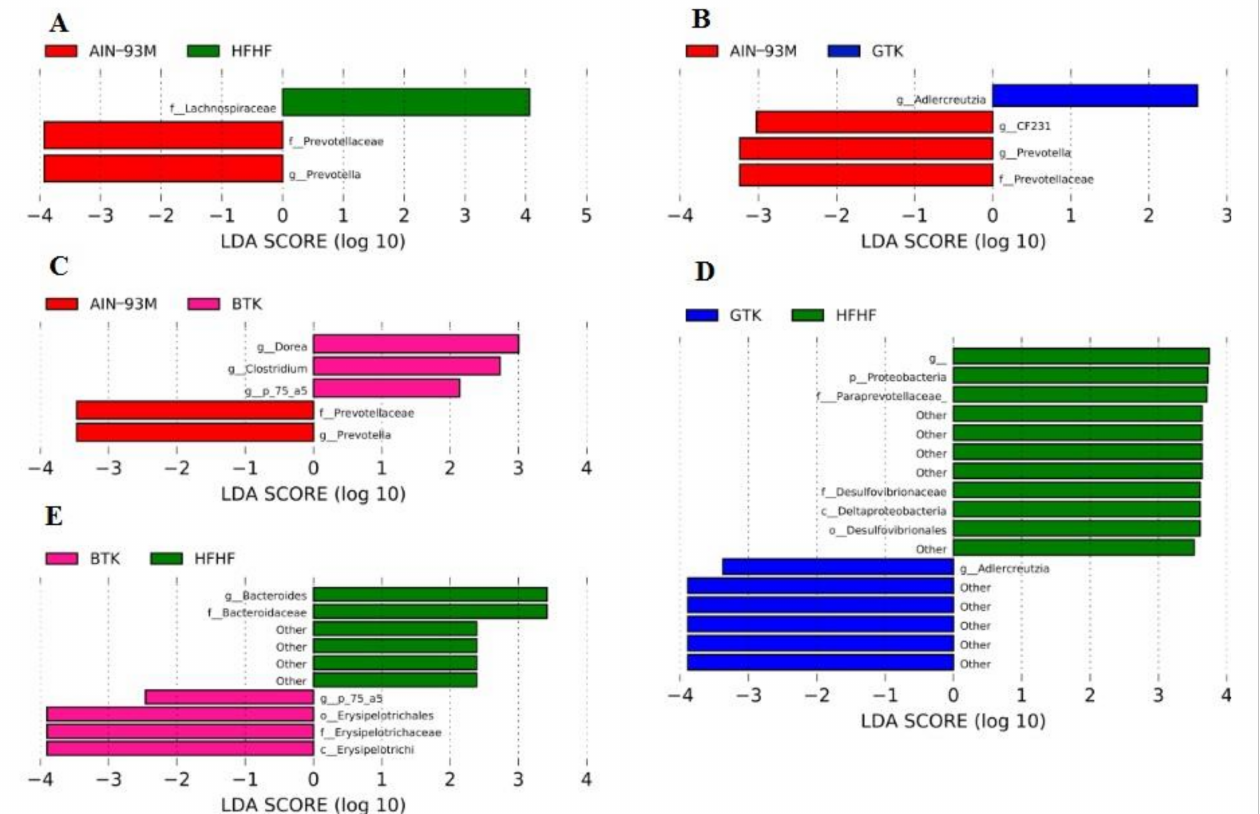
Figure 6. Differential abundance analysis was conducted with Linear discriminant analysis Effect Size (LEfSe) following the experimental period. Comparisons were made between AIN-93M with HFHF ( A ); GTK ( B ); and BTK ( C ) groups and between HFHF with GTK ( D ) and BTK ( E ) groups. Only biomarkers showing linear discriminant analysis (LDA) scores greater than 2.0 with a false discovery rate (FDR) p < 0.05 are depicted. Letters: p, phylum; c, class; o, order; f, family; g,